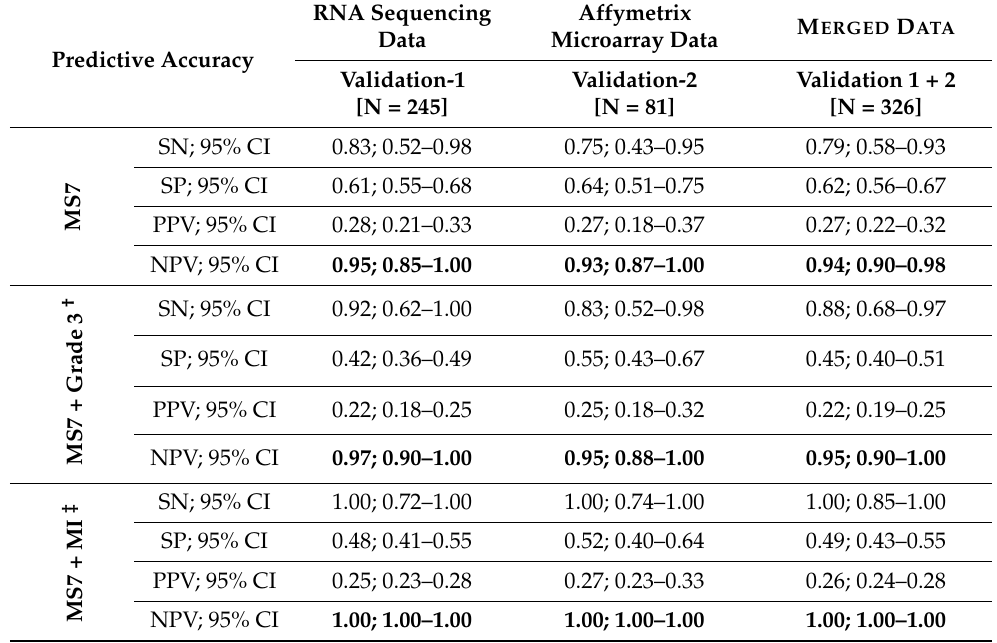
Table 3. The predictive accuracy of different companion diagnostic models for nodal and distant metastasis in endometrioid endometrial cancer patients with either stage I or stage IIIC/IV disease.